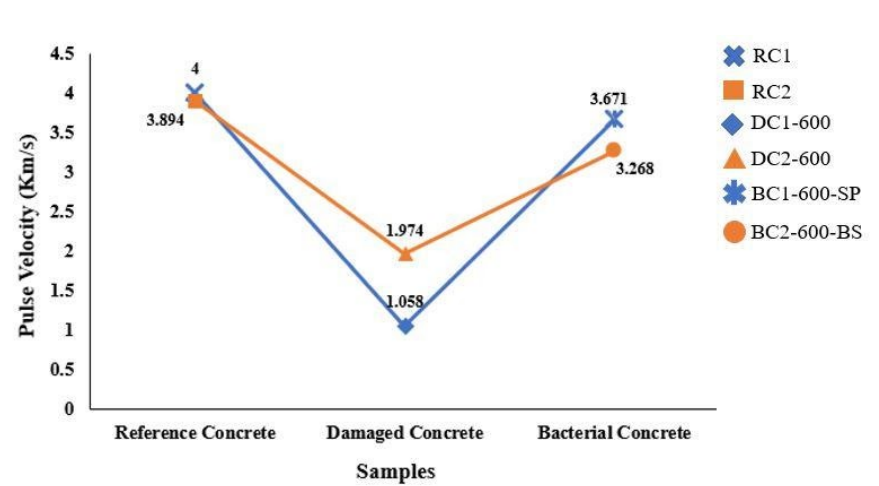
Figure 6. Comparing the ultrasonic pulse velocity results of the control specimens, damaged at 600 °C and repaired by type I and II bacteria.